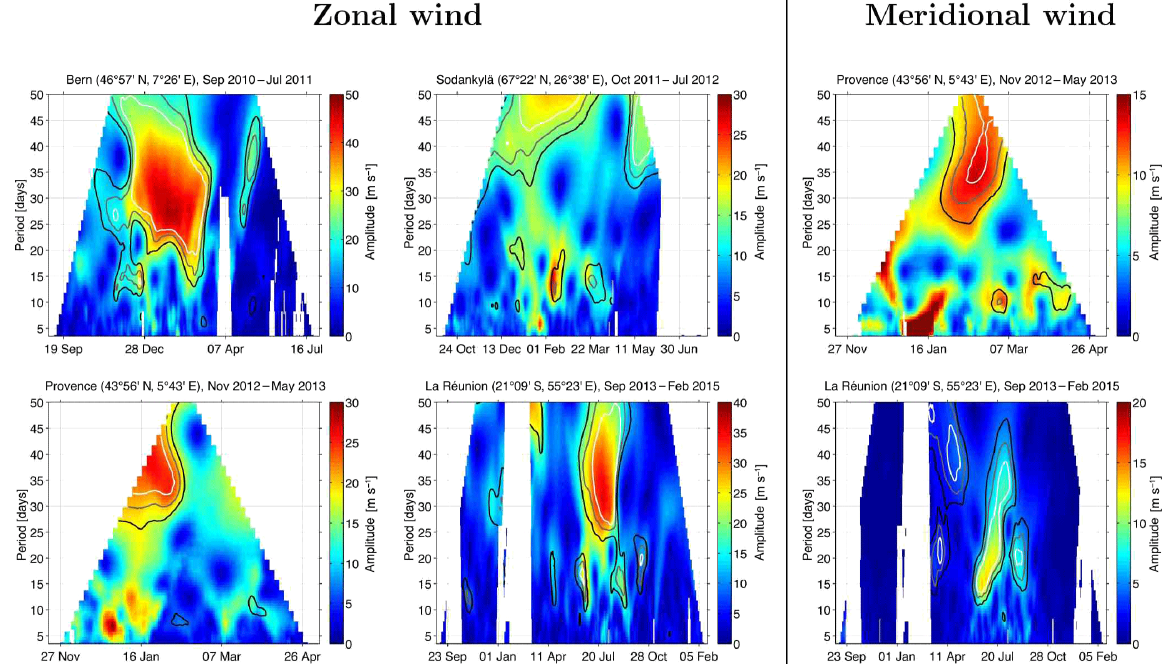
Figure 6. As Fig. 5 but for the scenario ECMWF at